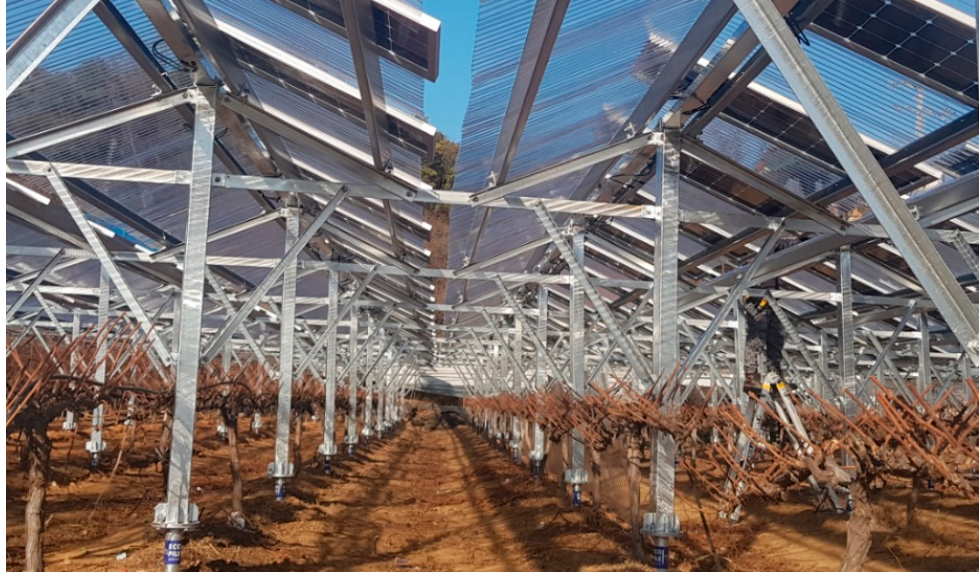
Figure 3. Rain-hit-protection solar facility in a grape farm.